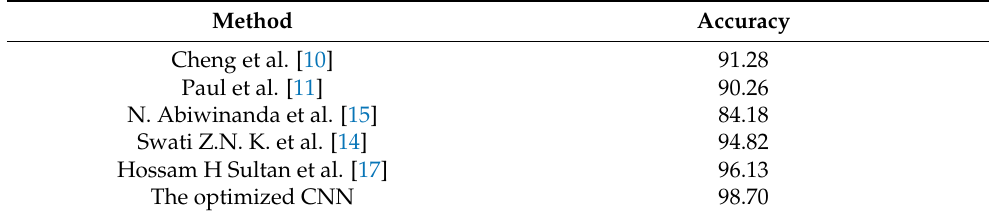
Table 9. Accuracy comparison among the optimized CNN model and state-of-the-art methods.